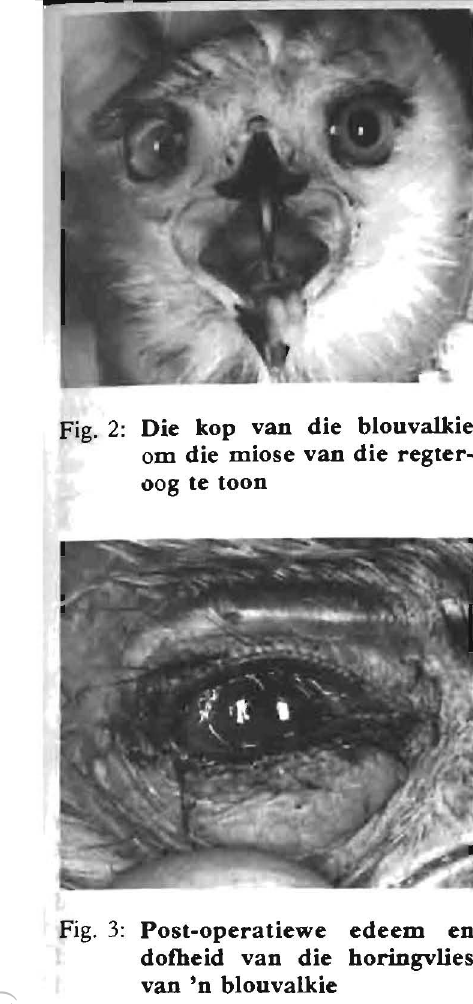
Fig. 3: Post-operatiewe edeem en dofheid van die horingvlies van 'n blouvalkie normale soutoplossing. Die kantotomie snit is met 2 enkel onderbroke Vicryl steke